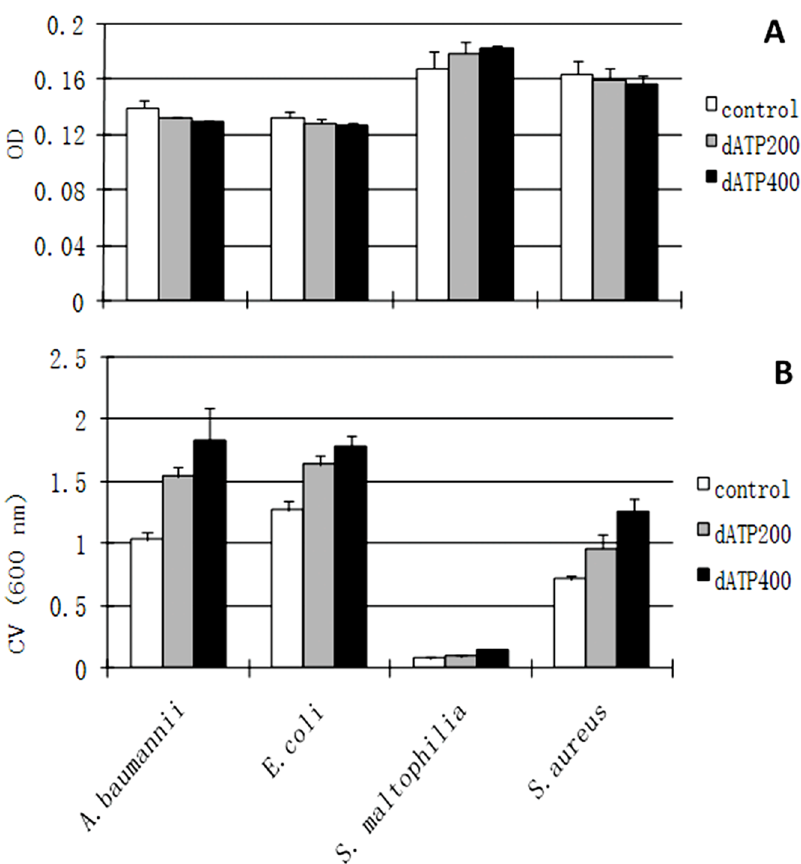
Figure 3. Growth and biofilm formation of different strains in the absence (control) or the presence of dATP (dATP200, 200 m M of dATP; dATP400, 400 m M of dATP). 1% overnight culture were inoculated in 100 m l of 10% LB broth in wells of 96-well microtiter plate with different concentration of dATP, 10% LB without dATP was set as control. A, growth OD was measured by reading absorbance at 600 nmafter 16 hours incubation at 30 u C. B, biofilm biomass was recorded by reading absorbance at 600 nm after crystal violet staining. Statistical analysis of three independent experiments showed significant increase of biofilm formation by all strains in the presence of dATP.